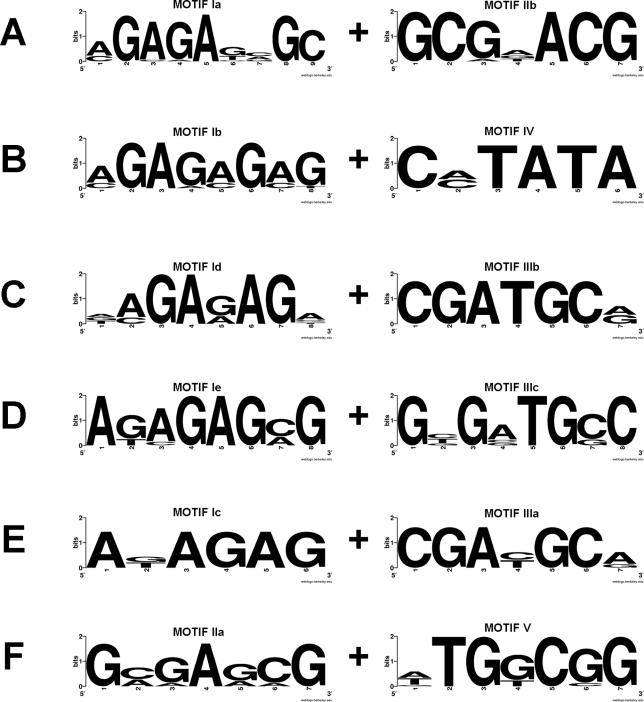
DNA Sequence Logos of Representative Motifs Putatively Involved in DCC BindingLogos (generated using the WebLogo software) represent degenerate motifs based on related pairs of elements from Table S1. The logos were generated by aligning all the words of related elements from specific pairs: (A) pairs 5, 6, 7, 8, 9, and 10; (B) pairs 11, 12, 13, and 14; (C) pairs 17, 18, 19, and 20; (D) 21, 22, and 23; (E) pairs 15 and 16; and (F) pairs 1, 2, and 3. Pairs 4 and 24 were not included. Motifs Ia–Ie all contain GAGA-related sequences. Motifs IIa and IIb as well as IIIa–IIIc are also related to each other.